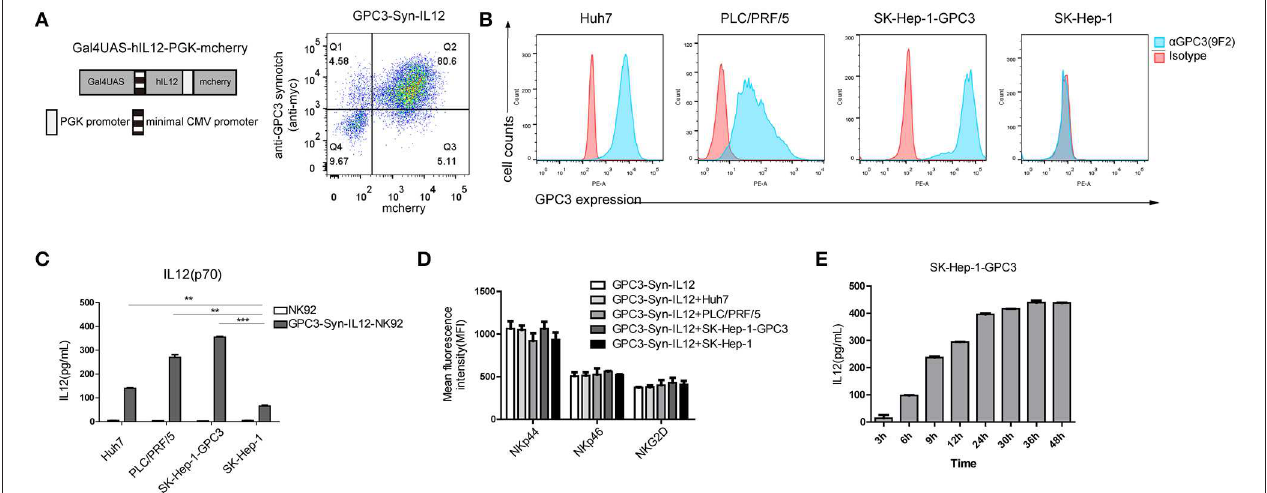
FIGURE 2 | Target-dependent expression of IL12 by the synNotch receptor. (A) Schematic representative of GPC3-Syn-IL12 and the transduction efficiency of GPC3-Syn-IL12 in NK92 cells. (B) Surface GPC3 expression (blue) on HCC cell lines was detected by FACS analysis. Isotype antibody control (red) served as controls. (C) GPC3-Syn-IL12 NK92 cells co-cultured with the indicated target cell lines for 24h. Culture supernatants were assayed for secreted IL12 by ELISA. (D) Flow cytometry analyses of the phenotypic characterization of GPC3-Syn-IL12 NK92 cells co-cultured with different target cell lines for 24h. Surface expression of NKp44, NKp46 and NKG2D was assessed using mean fluorescence intensity (MFI). The data presented are the quantitative data. (E) IL12 levels produced by GPC3-Syn-IL12 NK92 cells stimulated by SK-Hep-1-GPC3 cells after different time points. Each experiment was repeated at least twice with similar results. Data are presented as the mean ± SEM, and significant differences between groups were measured by using one-way analysis of variance (ANOVA). ** P < 0.01, *** P < 0.001. Only significant differences are